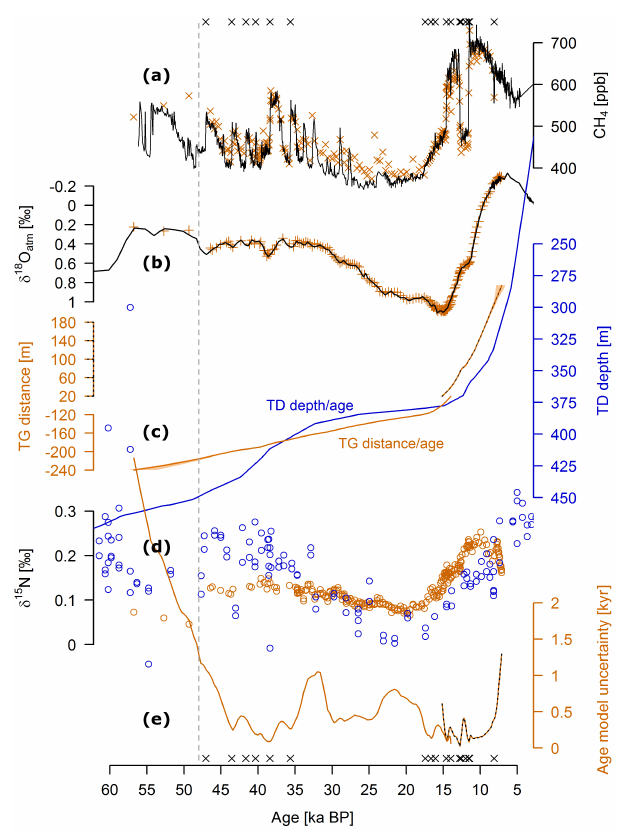
Figure 6. (a) Methane records from WAIS Divide (black; Buiz- ert et al., 2015) and Taylor Glacier (orange, this study and Bauska et al., 2016). Taylor Glacier methane data are a combination of field and lab analyses. WAIS Divide data are on the WD2014 timescale. (b) δ 18 O atm records from WAIS Divide (black) and Taylor Glacier (orange). (c) Taylor Dome depth–age curve (blue, from Steig et al., 1998, and Sucher, 1997), and Taylor Glacier distance–age relation (orange). The Taylor Dome timescale is based on methane synchro- nization to GISP2 (Brook et al., 2000; Ahn and Brook, 2007). (d) δ 15 N from Taylor Dome (Sucher, 1997) and Taylor Glacier (or- ange). (e) Width of the 90% confidence interval of the TG gas model age distribution. Black crosses on the top and bottom of the plot show fixed tie points used in the WAIS Divide–Taylor Glacier synchronization (see Table 1). The dashed gray line marks the switch from well-constrained stratigraphy to older ice where more work is needed to construct a robust age